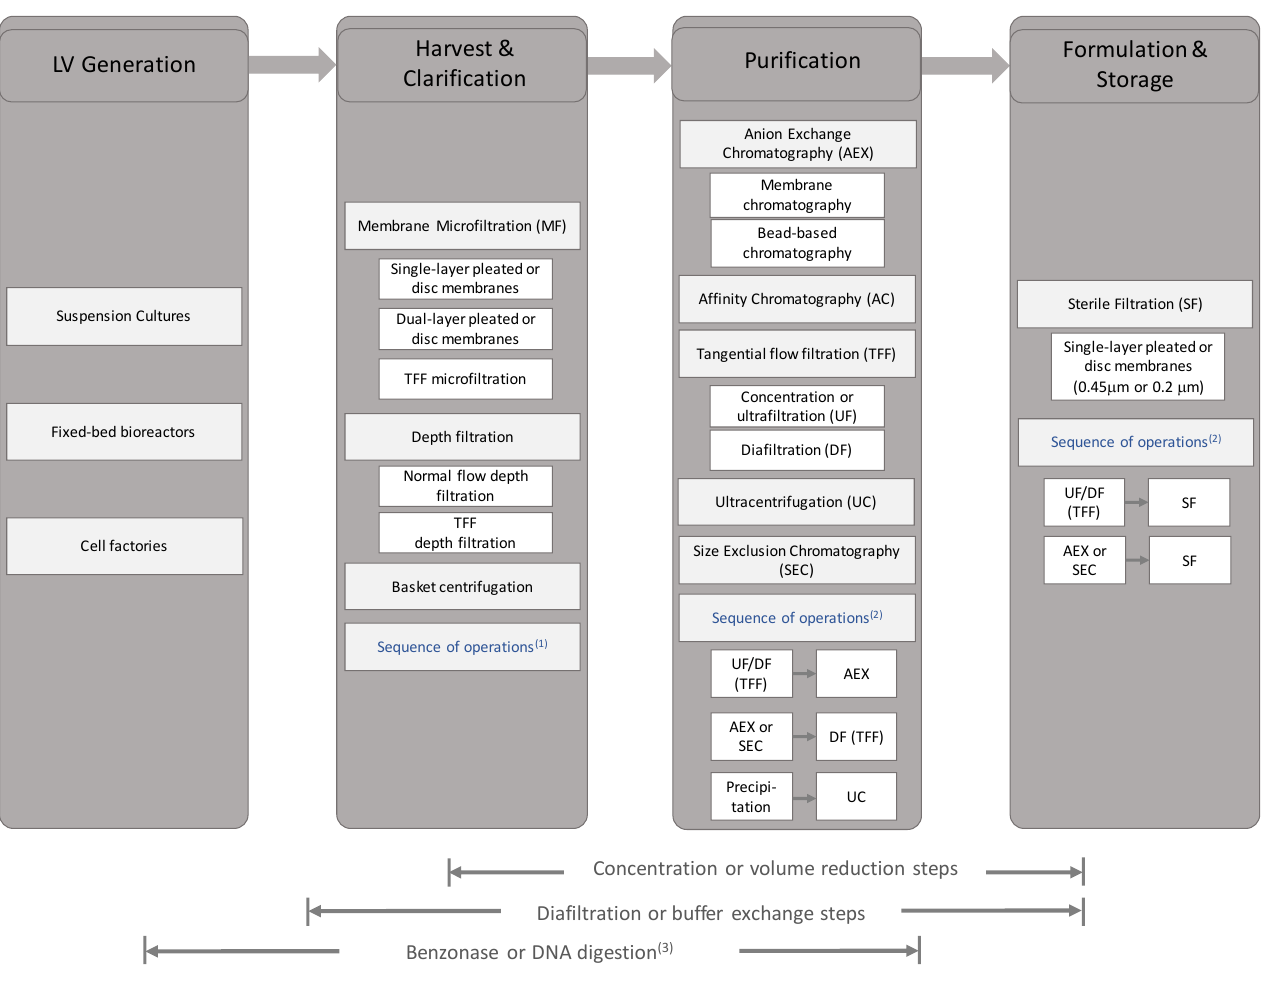
Figure 2. Bioprocess options in the production of lentiviral vectors. ( 1 ) Some studies have shown sequence of membrane filtration of different pore sizes or inclusion of low-speed centrifugation prior [145,183,189]. Sequence of filtration processes would be an option depending on scale and cell density and product and impurity profile. ( 2 ) These are examples of sequences of operations used in pre-clinical and clinical investigations [145,268,269]. ( 3 ) Benzonase may be added at a variety of steps within the downstream